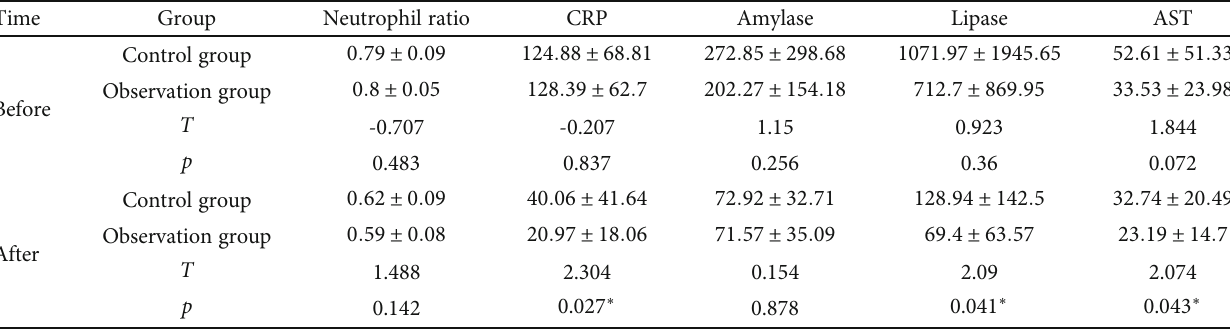
(a) Analysis of serum-related indicators in the two